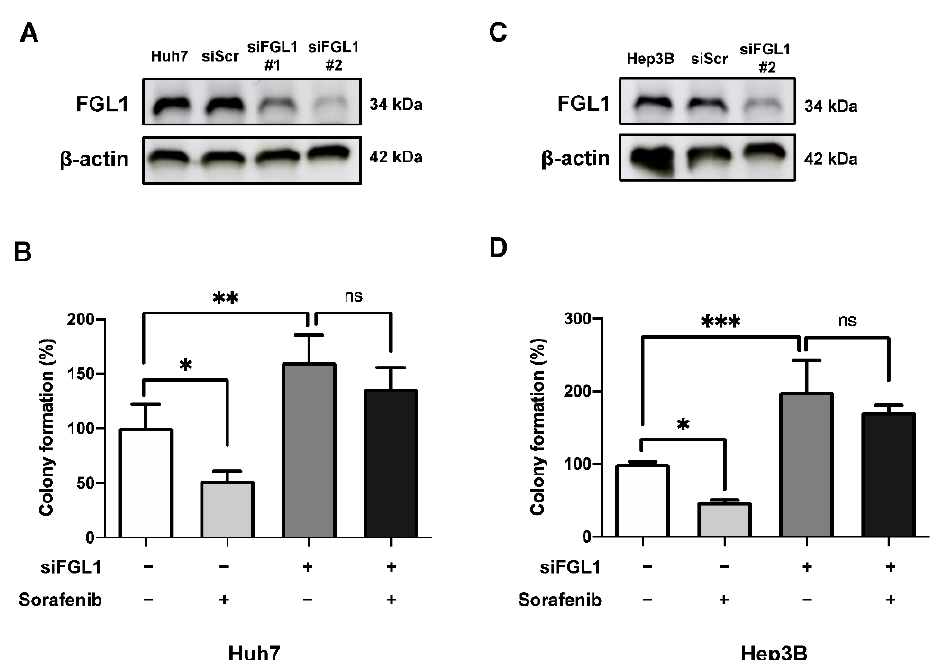
Figure 4. Effect of silencing FGL1 in Huh7 and Hep3B cells on their sorafenib sensitivity. ( A ) Ex- pression of FGL1 in Huh7 cells 24 h after FGL1 siRNA transfection. ( B ) Colony formation of Huh7 cells following siFGL1 and/or sorafenib (2 µ M) treatment. ( C ) Expression of FGL1 in Hep3B cells 24 h after FGL1 siRNA transfection. ( D ) Colony formation of Hep3B cells following siFGL1 and/or sorafenib (2 µ M) treatment. Graphs present mean ± standard deviation values (n = 4). * p < 0.05, ** p < 0.01, and *** p < 0.001, significantly different from scrambled siRNA-treated cells. siFGL1 ( − ), treated with siScr; Sorafenib ( − ), treated with vehicle (DMSO); siScr, scrambled siRNA; siFGL1, FGL1 siRNA.